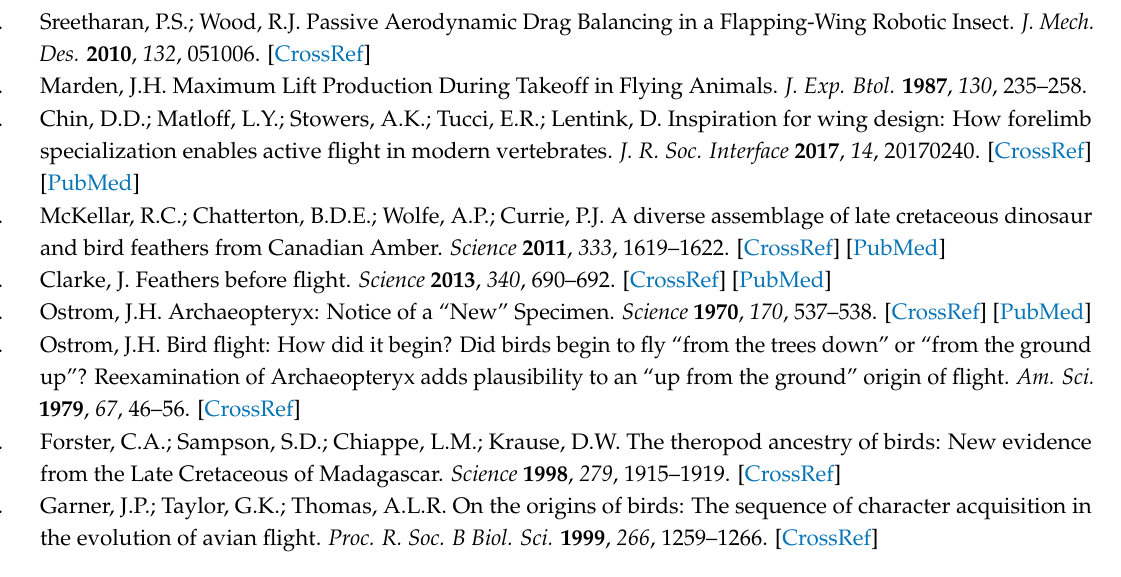
Figure S1. Reconstruction of airfoil of Anchiornis huxleyi ; Figure S2. Interpolated lift coefficient, drag coefficient, and the ratio of lift to drag; Figure S3. Trajectories of Anchiornis running at a speed of 6 m/s and θ = 30 ◦ ; Figure S4. Trajectories of Anchiornis running at a speed of 7 m/s and θ = 30 ◦ ; Figure S5. Trajectories of Anchiornis running at a speed of 8 m/s and θ = 30 ◦ ; Figure S6. Trajectories of Anchiornis running at a speed of 6 m/s and θ = 10 ◦ ; Figure S7. Trajectories of Anchiornis running at a speed of 7 m/s and θ = 10 ◦ ; Figure S8. Trajectories of Anchiornis running at a speed of 8 m/s and θ = 10 ◦ ; Figure S9. Trajectories of Anchiornis running at a speed of 6 m/s and θ = 0 ◦ ; Figure S10. Trajectories of Anchiornis running at a speed of 7 m/s and θ = 0 ◦ ; Figure S11. Wing-assisted incline running helped Anchiornis huxleyi climb the mountain; Figure S12. Forces acting upon a winged theropod during stable gliding flight; and Table S1. Simulation results of the lift and drag coefficients for the thin plate reconstructed in the scale of 1:1 according to the fossil using the ANSYS